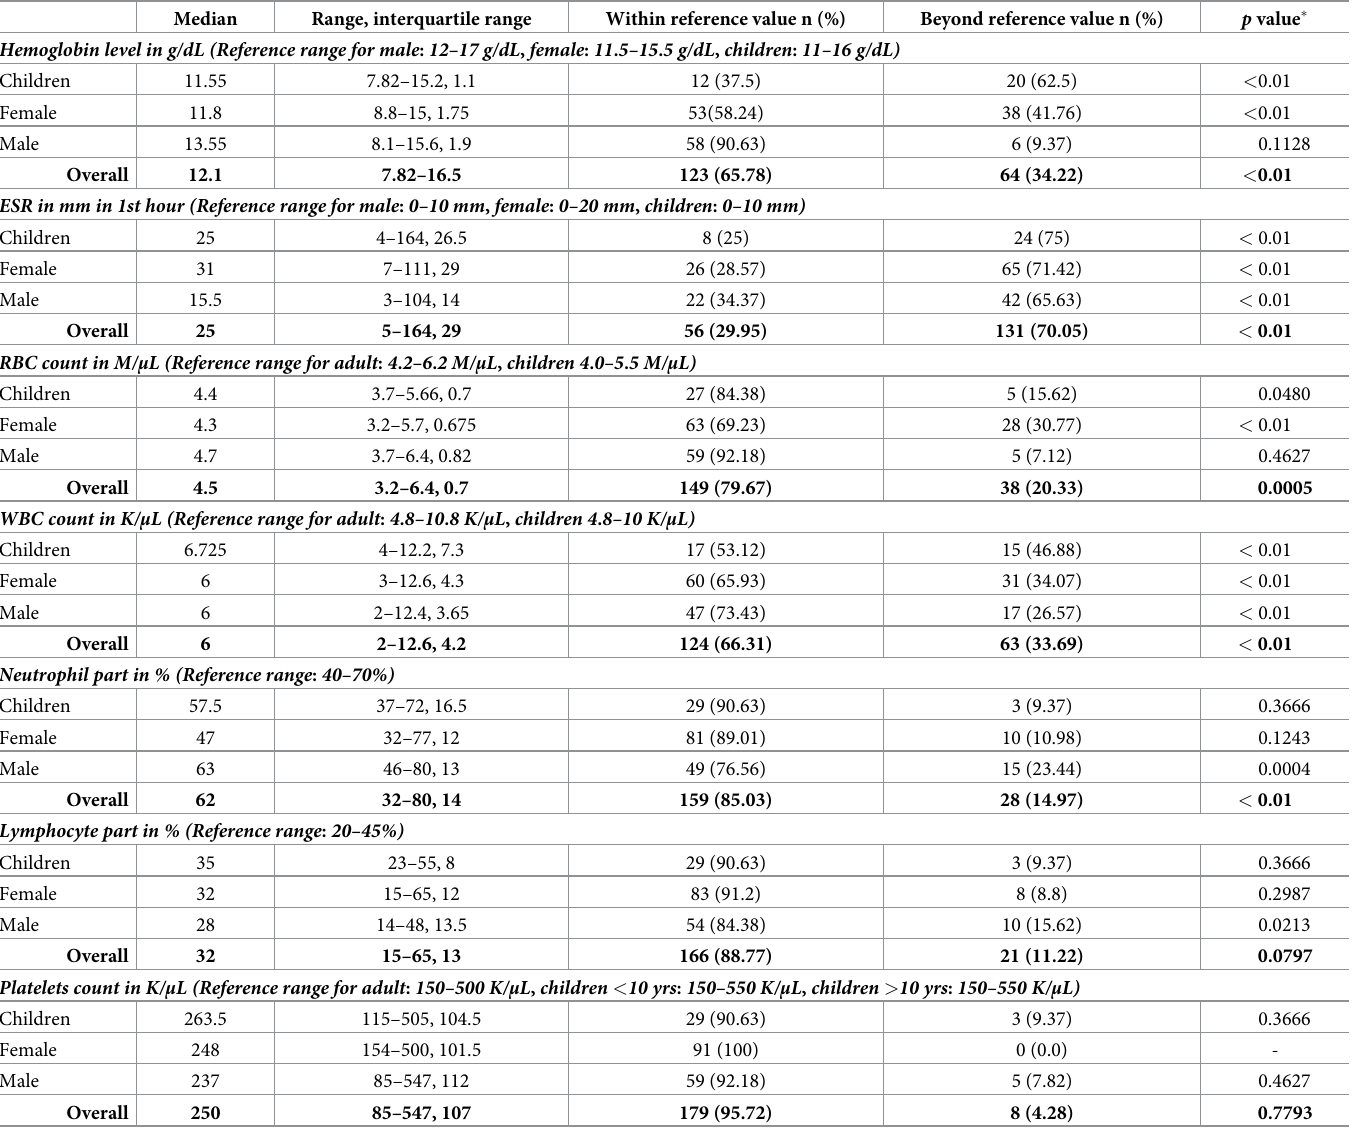
Table 5. Sex-specific hematological findings in CHIKV positive patients according to age groups. Median Range, interquartile range Within reference value n